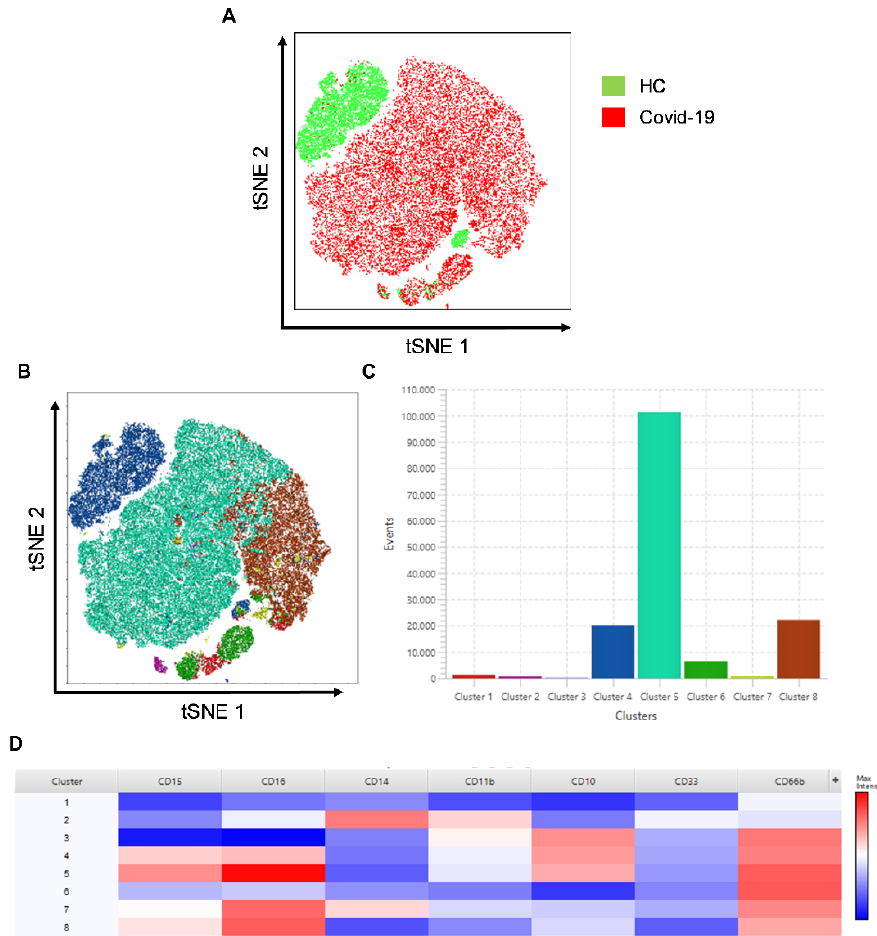
Figure 3. Distinct neutrophil clusters in COVID-19 patients in t-SNE. ( A ) Representation of samples from COVID-19 patients and healthy control by unified in t-SNE analysis, demonstrating difference in clustering of CD66b+ live-cell populations. ( B ) t-SNE graph with 8-cluster FlowSOM analysis. ( C ) Graph demonstrating the number of events of each cluster. ( D ) Heatmap analysis of the clusters demonstrating the cell markers .